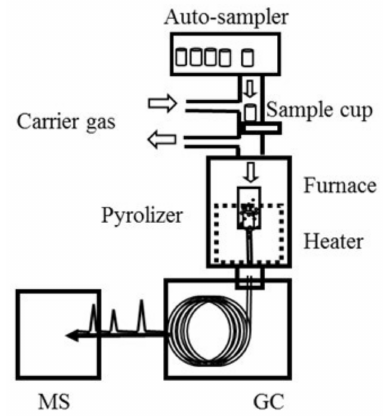
Figure 8. Schematic of the Py/TD-GC–MS